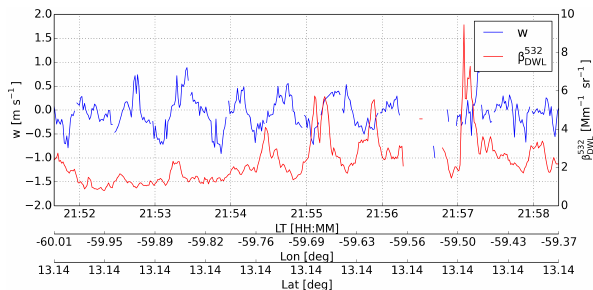
Figure 14. Retrieved backscatter coefficient (red) and vertical wind speed (blue) on the lee side of Barbados during the flight of the 2nd leg at an altitude of 1600m. Due to the presence of clouds, data between 21:56 and 21:57LT are